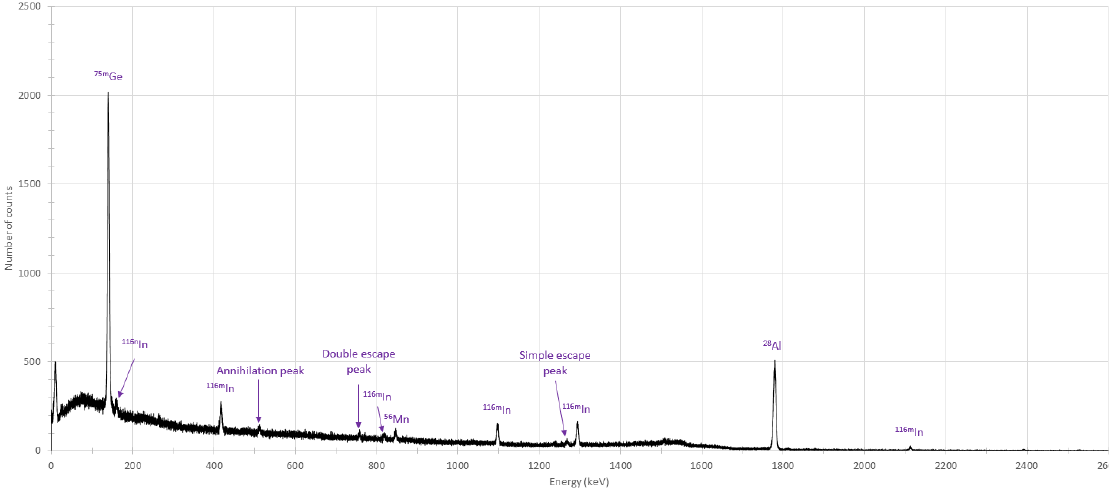
Fig. 11. Delayed gamma-ray spectrum of the background obtained with the setup No.